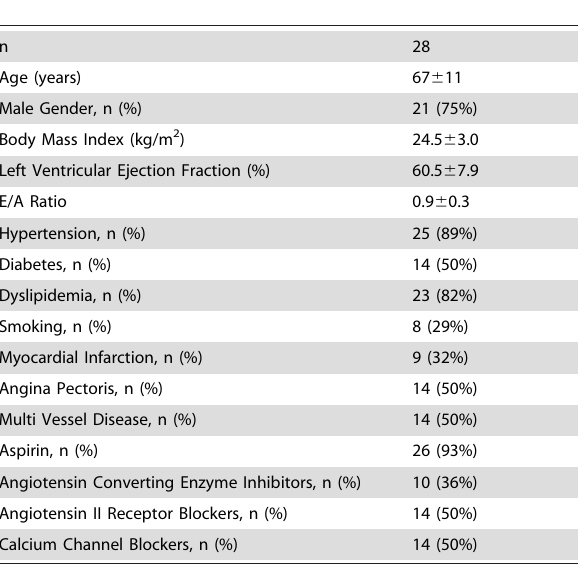
Table 1. Patients’